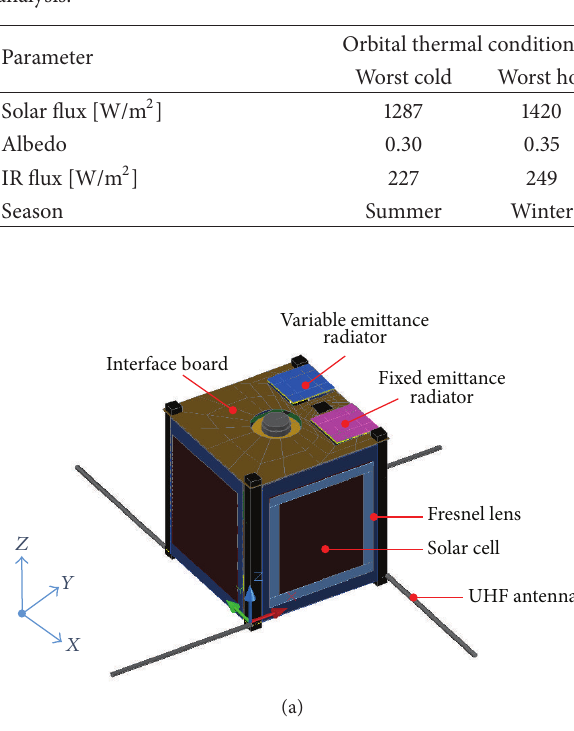
in which the satellite is operated at the emergency condition when the EPS, OBC, and communication boards are operated during the summer solstice with the lowest incoming heat